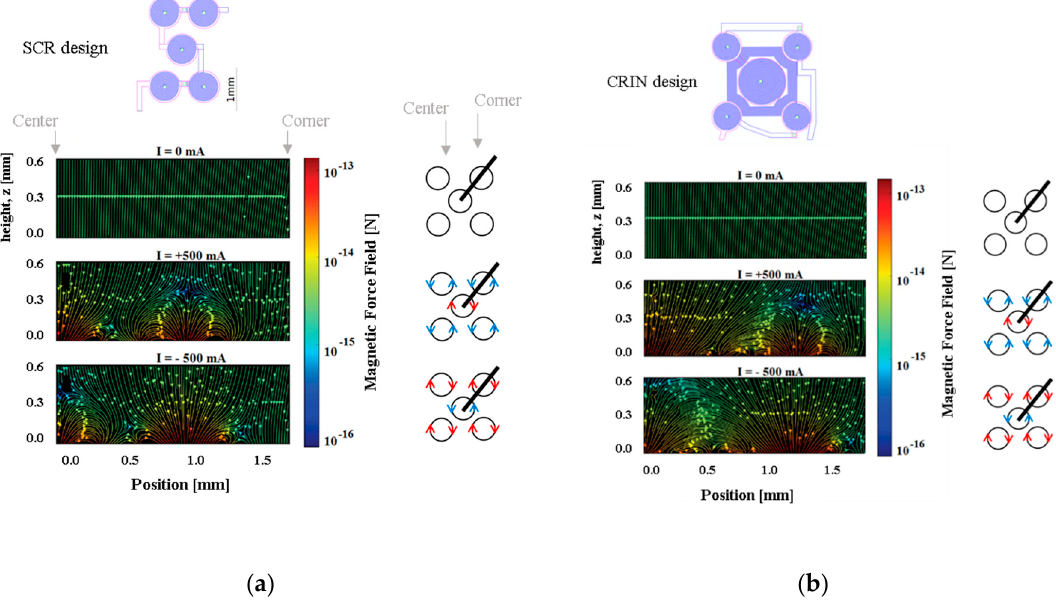
Figure 6. Plots for the ( a ) SRC design. At approximately z = 200 µm the force field moves beads between coils, but below z = 100 µm the field moves beads between the interior and contour of each coil ( b ) CRIN design. The field becomes effective at moving beads between coils at z = 50 µm.